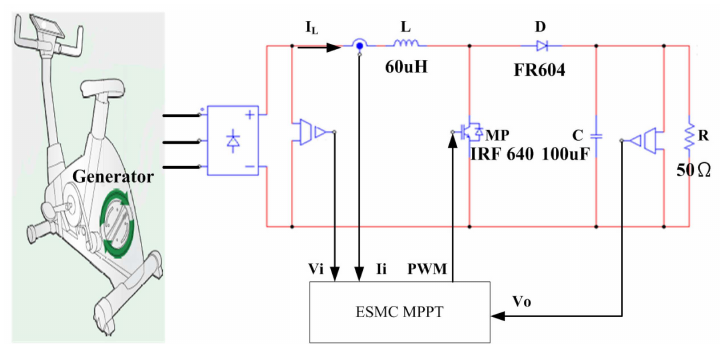
Figure 3. The boost converter architecture for GBEE.